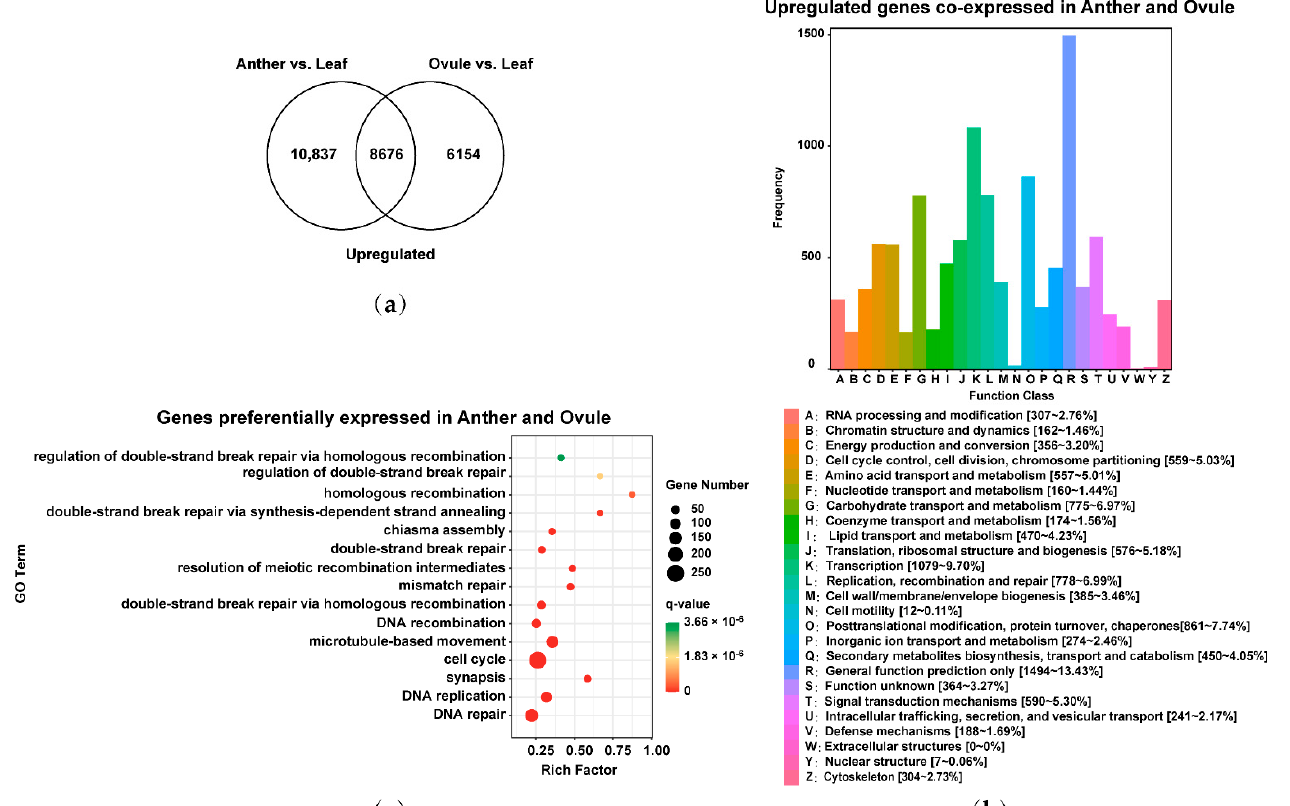
Figure 2. Identification and functional analysis of upregulated genes co-expressed and preferentially expressed genes in Anther and Ovule of Brassica allohexaploids: ( a ) Venn diagram showing the overlap of upregulated genes between Anther vs. Leaf and Ovule vs. Leaf; ( b ) clusters of orthologous groups (COG) classification of upregulated genes co-expressed in Anther and Ovule; and ( c ) gene ontology (GO) biological process pathway enrichment analysis of preferentially expressed genes in Anther and Ovule.